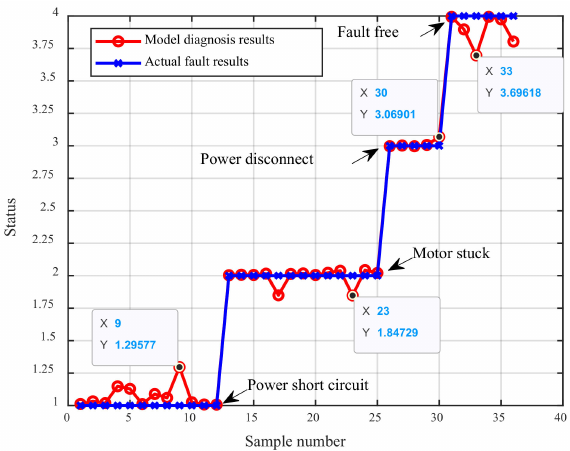
Figure 10. Fault diagnosis results.